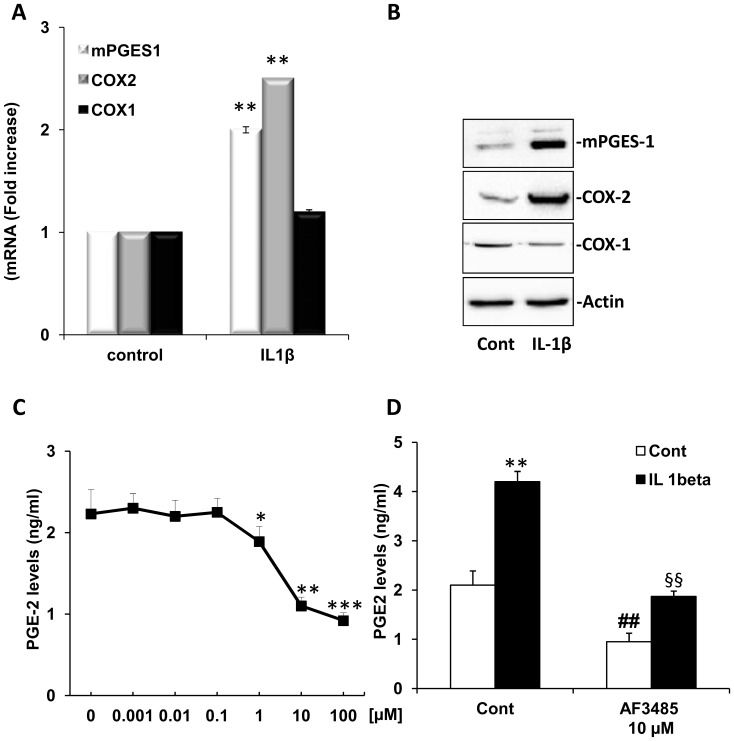
AF3485 inhibits IL-1β-induced PGE2 production in A431 cells.(A) COX-1, -2 and mPGES-1 mRNA expression in A431 cells in presence/absence of IL-1β (10 ng/ml, 18 h). Data reported as fold increase vs. unstimulated control. **P<0.01 vs Control. (B) Western blot of COX-1, -2, and mPGES-1 expression in A431 cells in presence/absence of IL-1β (10 ng/ml, 18 h). (C) PGE2 levels in unstimulated A431 cells treated with AF3485 (0–100 µM, 30 min). PGE2 levels measured by ELISA (24 h from plating.) Data reported as ng/ml. *P<0.05; **P<0.01; ***P<0.001 vs Control. (D) PGE2 levels in unstimulated or IL-1β (10 ng/ml, 24 h) pre-treated A431 cells, and treated with AF3485 (10 µM, 30 min). The data are reported as ng/ml. **P<00.1 vs Cont; ##P<0.01 vs Cont; §§P<0.01 vs IL-1β (10 ng/ml).